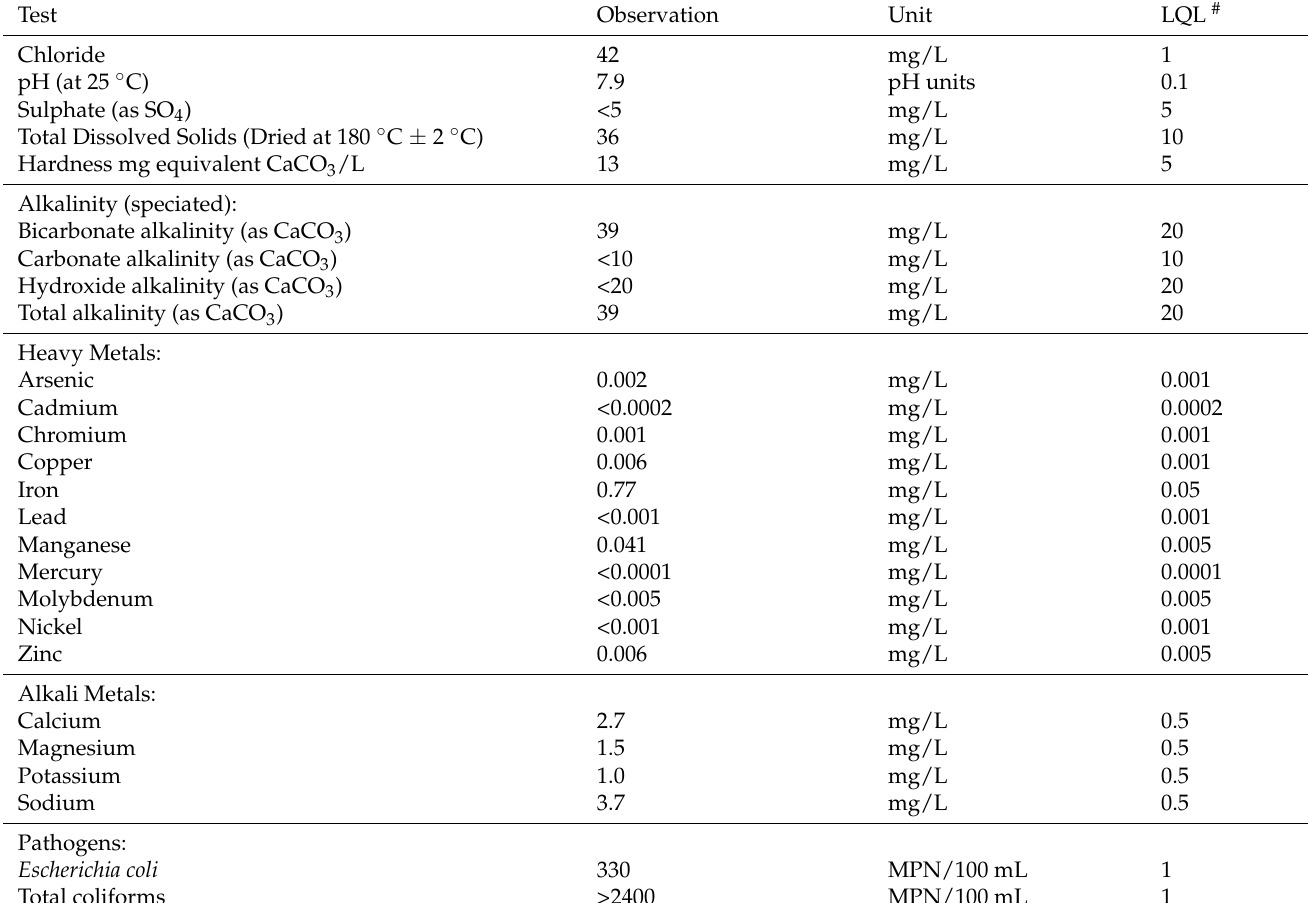
Table A2. Water quality analyses—Study 2a in Building B